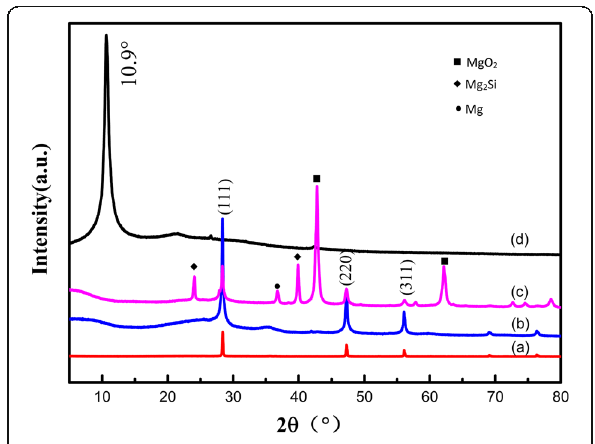
Fig. 2 XRD profiles of graphite oxide, pure silicon, MR-Si/G composite